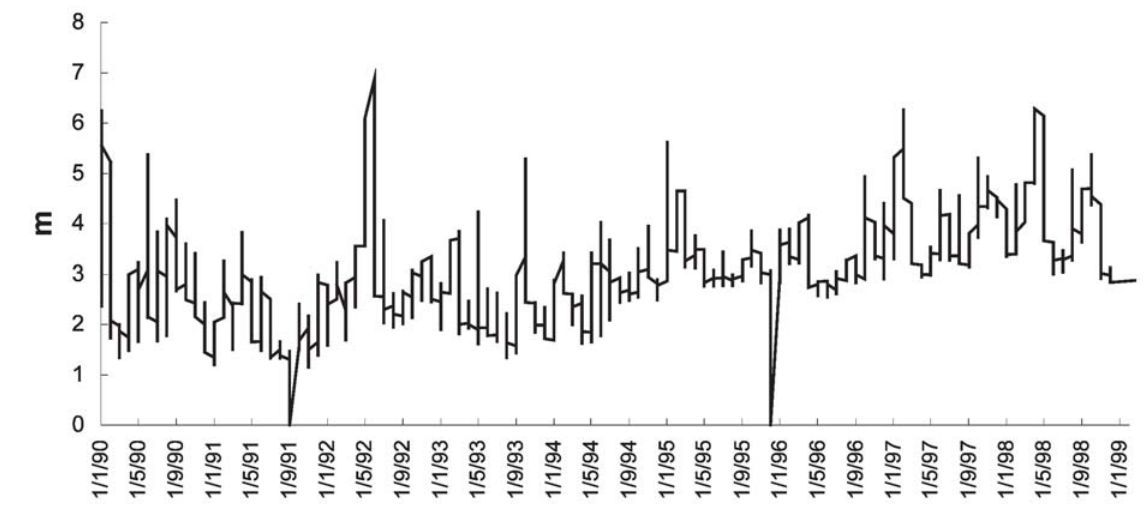
Fig. 2 . Water levels of the Paraná River at Posadas (Argentina). Values represent monthly average water levels